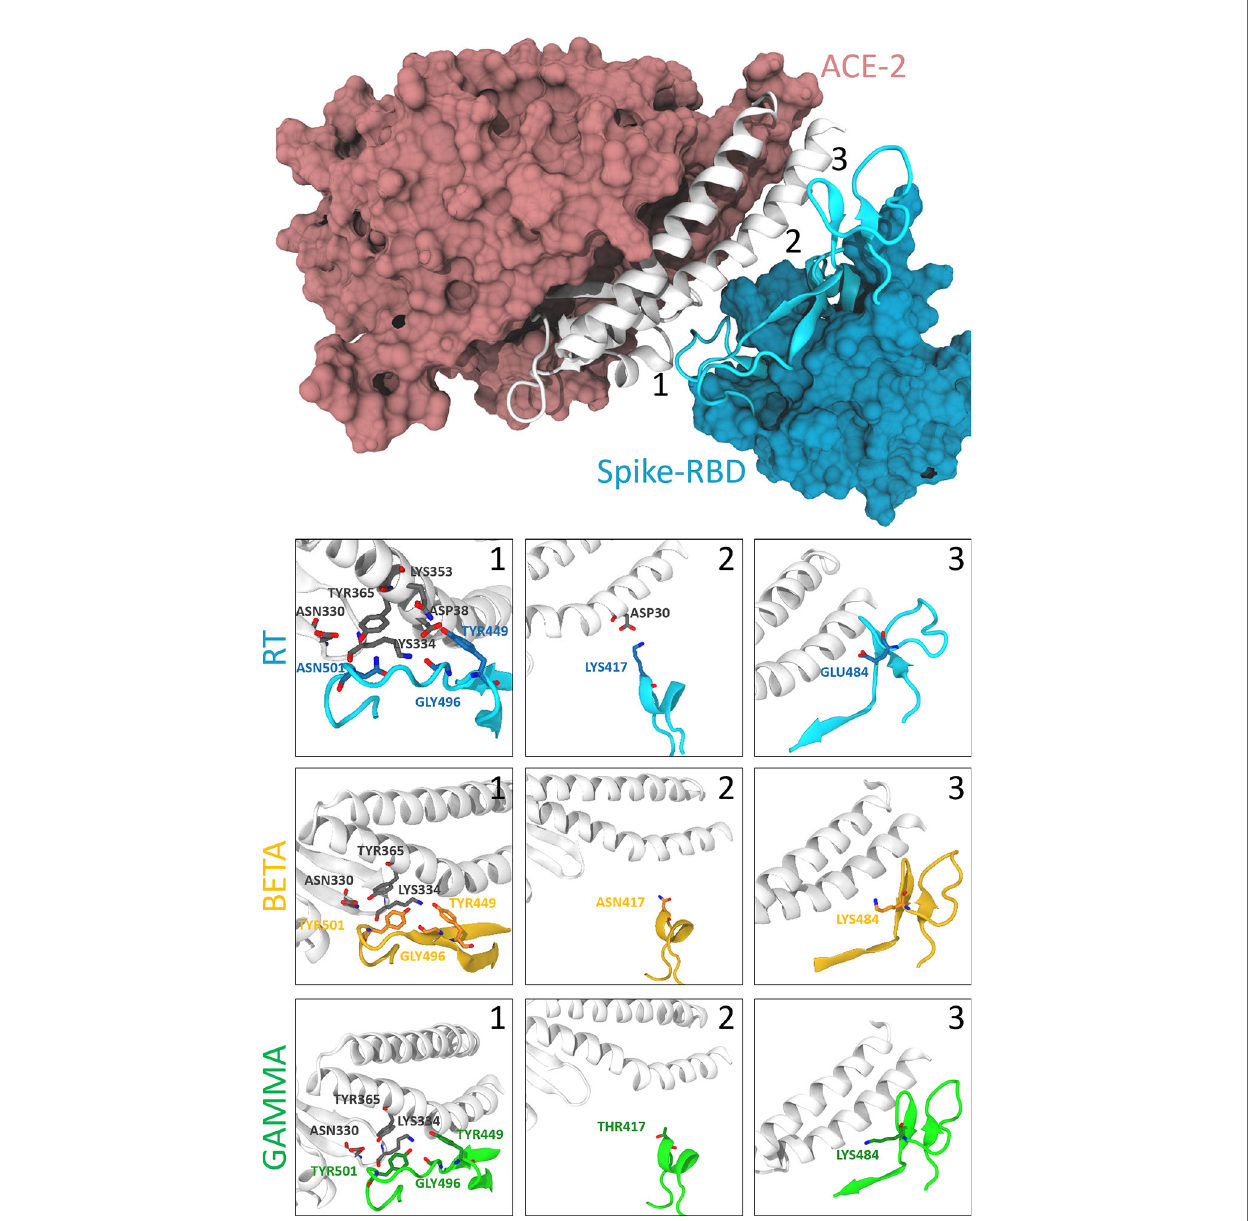
FIGURE 1 | Interactions between the spike protein and the hACE2 receptor. The top panel shows the binding between the S-RBD region of the RT and the hACE2 receptor. The interaction interface is shown in cartoon representation (white for hACE2 and cyan for S-RBD), while the rest of the protein is represented according to its surface (pink for hACE2 and light blue for S-RBD). The bottom panels show the differences between RT (cyan), beta (orange), and gamma (green) variants in correspondence with the position of the three S-RBD mutations (labeled with numbers 1-3 in the top panel). Relevant residues are shown with their side-chain representation in these panels. One can notice how residue Asn501 is at the center of a rich pattern of interactions, which is altered after its mutation to Tyr. On the other hand, Lys417 of the S-RBD interacts only with the Asp30 of the hACE2, and this interaction is broken after its modi fi cation to a non-basic amino acid. Finally, Glu484 does not show any critical interactions, and this does not change with the